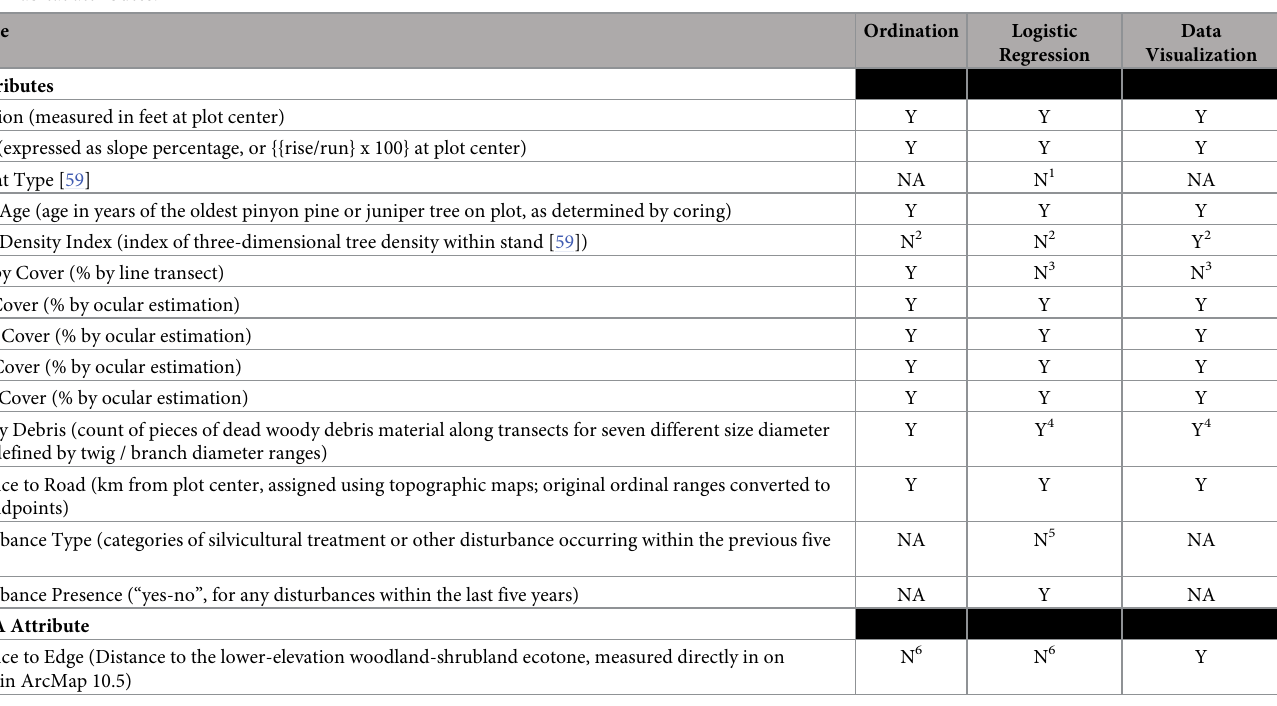
Table 2. Habitat